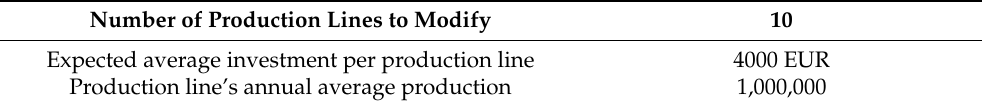
Table 2. Data used to calculate the savings achieved with ten critical lines. Number of Production Lines to Modify 10 Expected average investment per production line 4000 EUR Production line’s annual average production